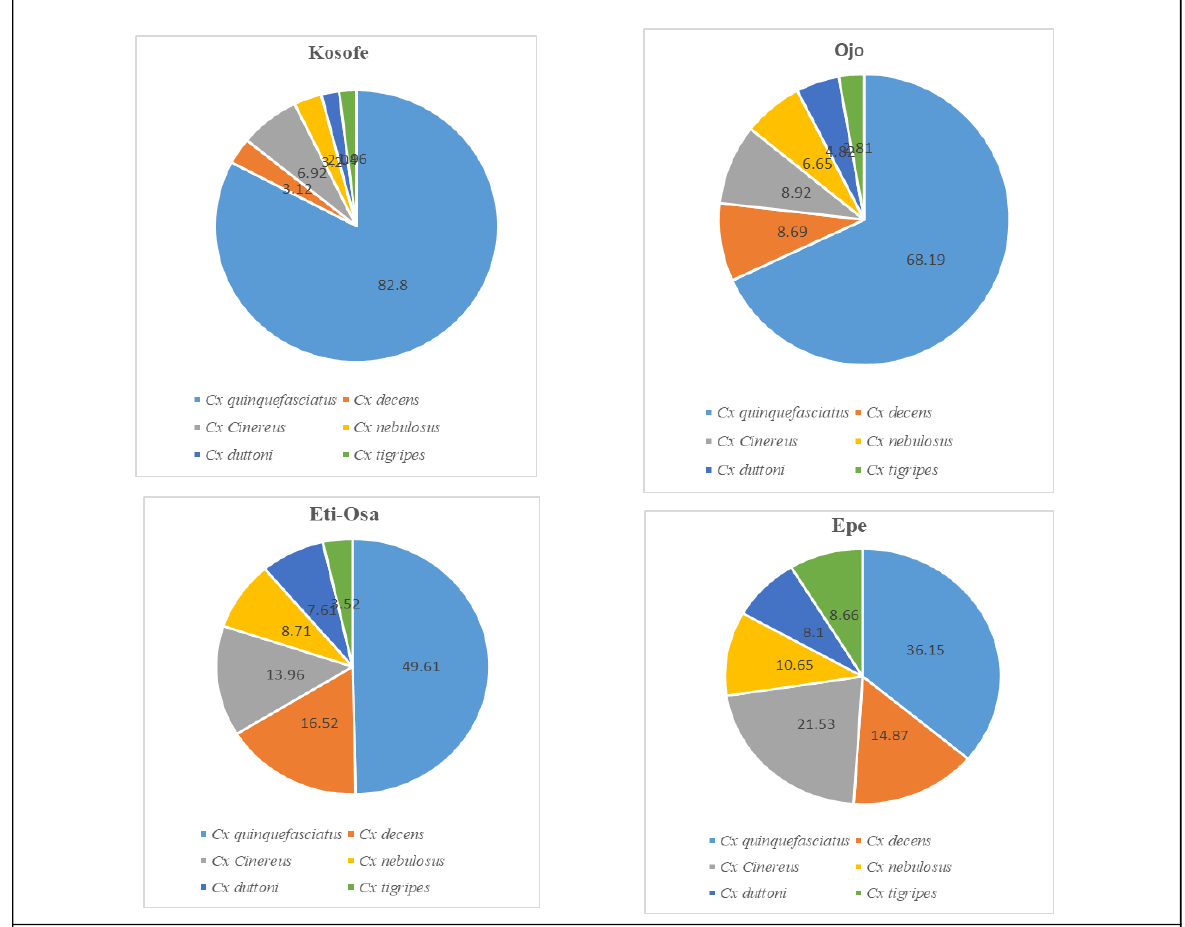
Figure 4: Culex species composition in the four selected Local Government Areas of Lagos